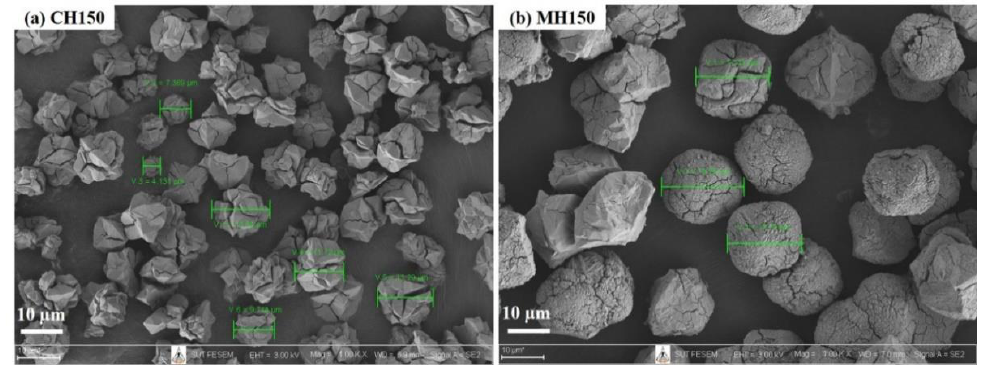
Figure 2. A field emission scanning electron microscopy (FESEM) images of the zeolite products from conventional and microwave-assisted hydrothermal methods with single crystallization at 150 °C for 24 h ( a , CH150) and 1 h ( b , MH150).